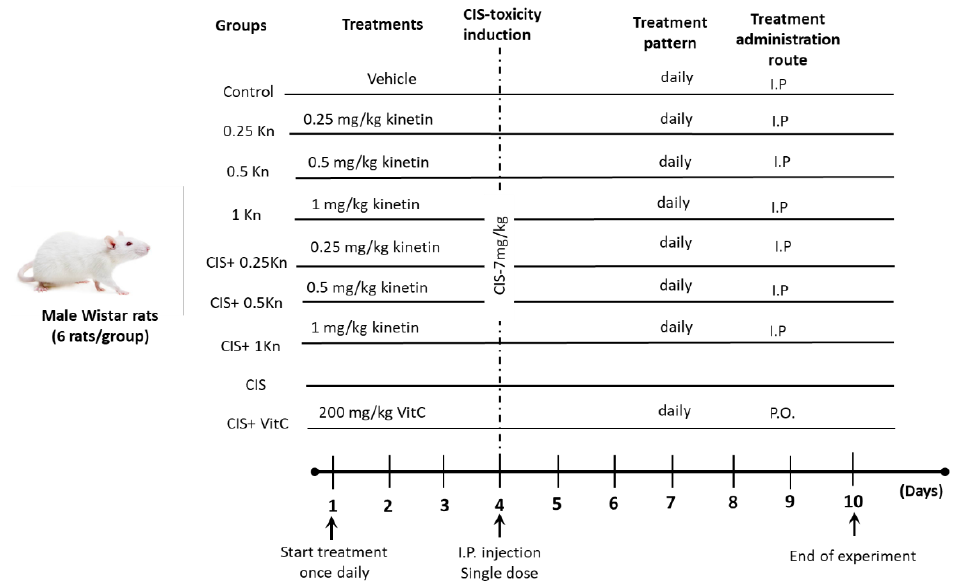
Figure 1. Schematic representation of the experimental design, showing the study groups and the timeline. I.P., intraperitoneal injection; P.O., oral administration; Kn, kinetin; CIS, cisplatin; VitC, vitamin C.